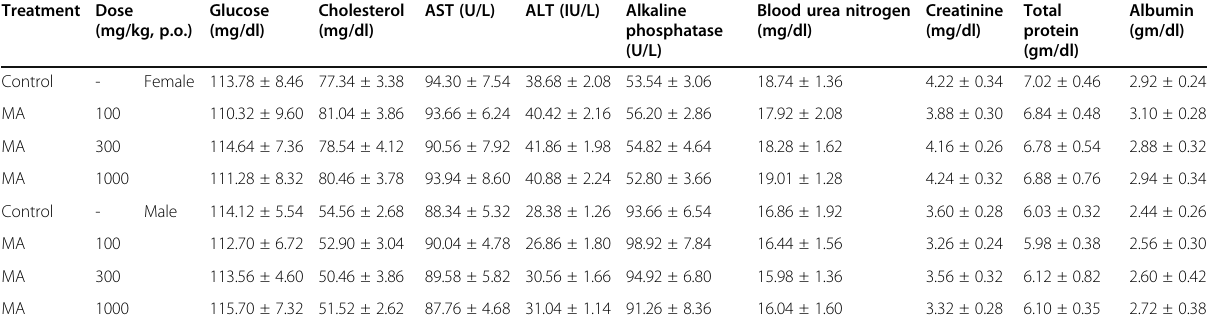
Table 2 Biochemical parameters of rats treated with (100, 300, 1000 mg/kg) MA for a period of 28 days Treatment Dose Glucose (mg/kg, p.o.)